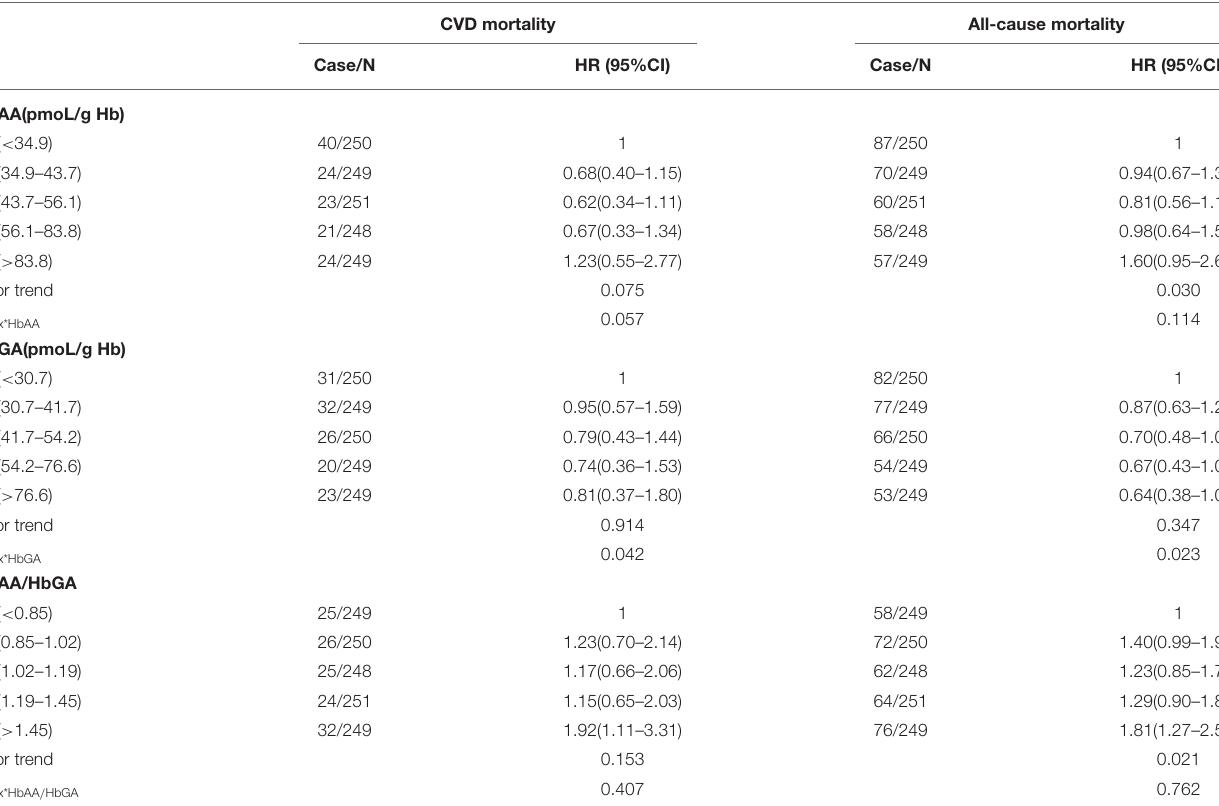
TABLE 3 | Adjusted HRs for the associations between HbAA, HbGA, HbAA/HbGA and CVD or all-cause mortality in diabetes population. CVD mortality All-cause